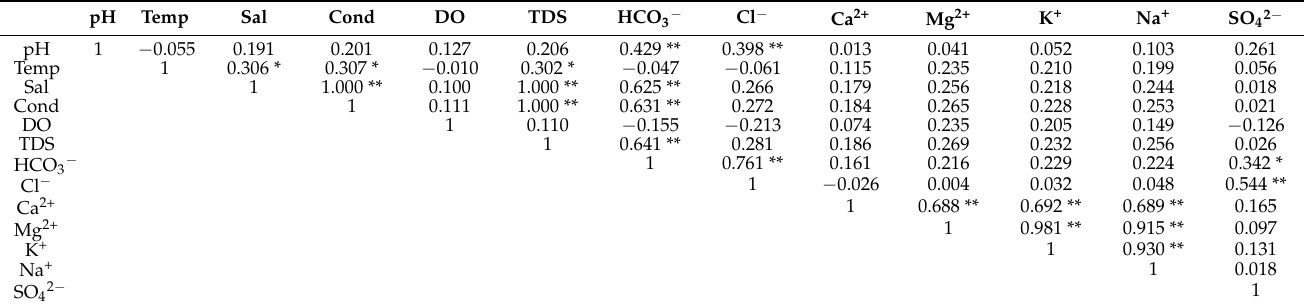
Table 6. Pearson’s product moment correlation of the physicochemical parameters and major ions. pH Temp Sal Cond DO TDS HCO 3 − Cl − Ca 2+ Mg 2+ K +